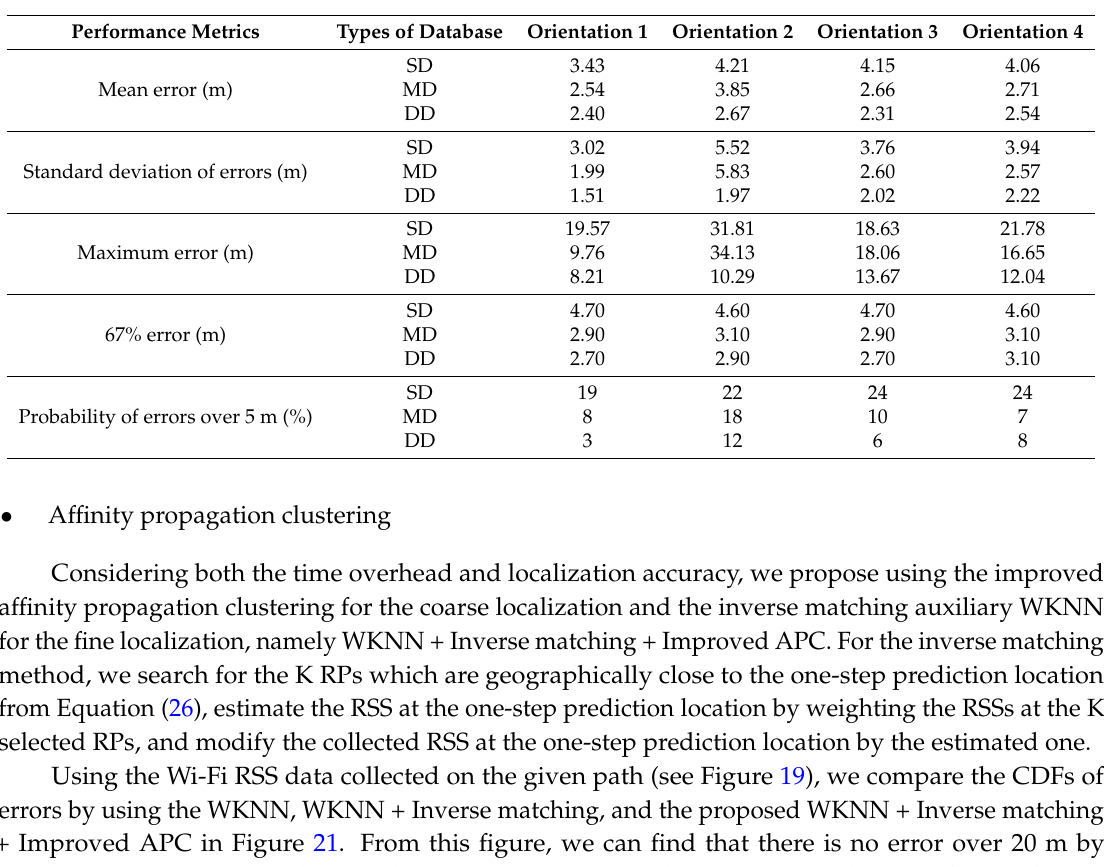
Figure 20. CDFs of errors by using different types of database. ( a ) Orientation 1; ( b ) Orientation 2; ( c ) Orientation 3; ( d ) Orientation 4. Table 1. Statistical errors by using different types of